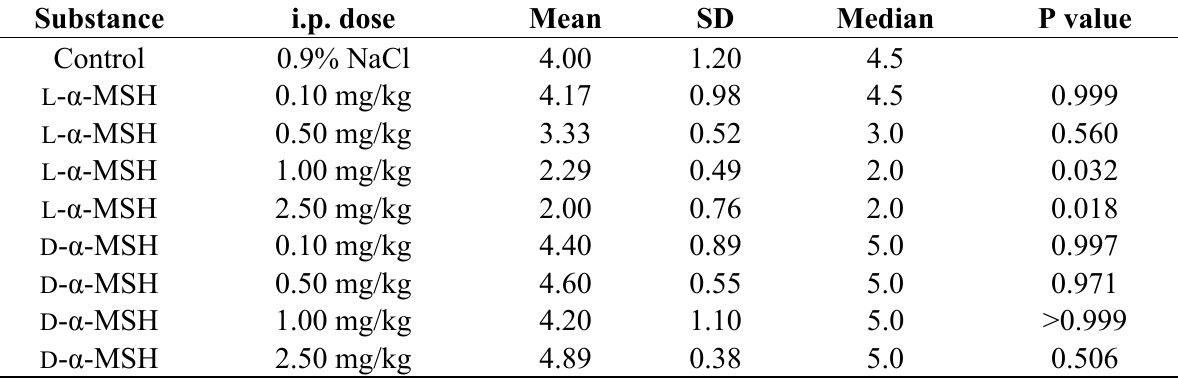
Table 3. Intensity of liver lesions 24 h after acetaminophen administration in controls and α -MSH treated